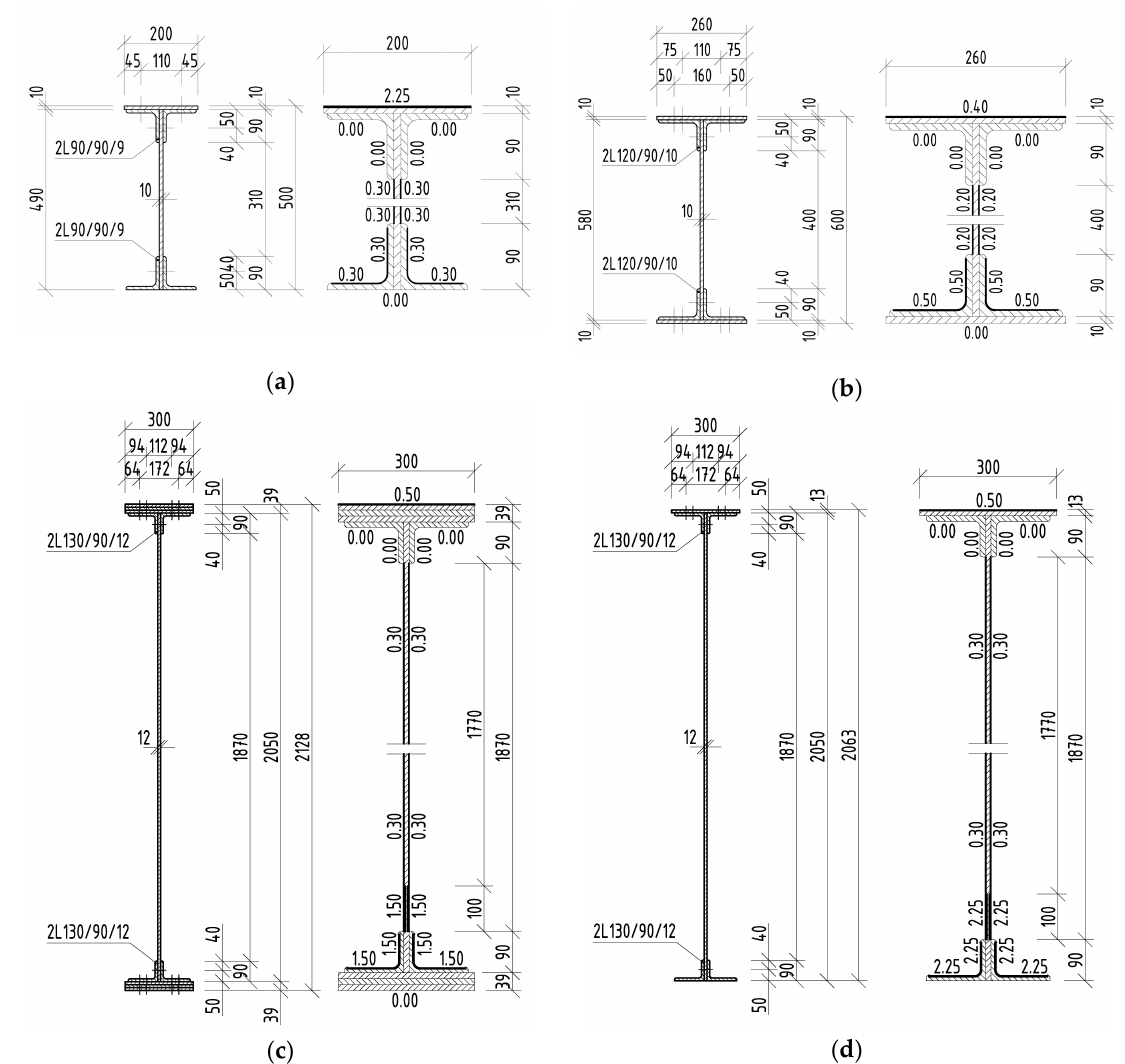
Figure 5. Riveted I-sections and average corrosion losses of elements in the case of Bridge 2: ( a ) right stringer; ( b ) crossbeam; ( c ) right main girder in the midspan; ( d ) right main girder near the support.